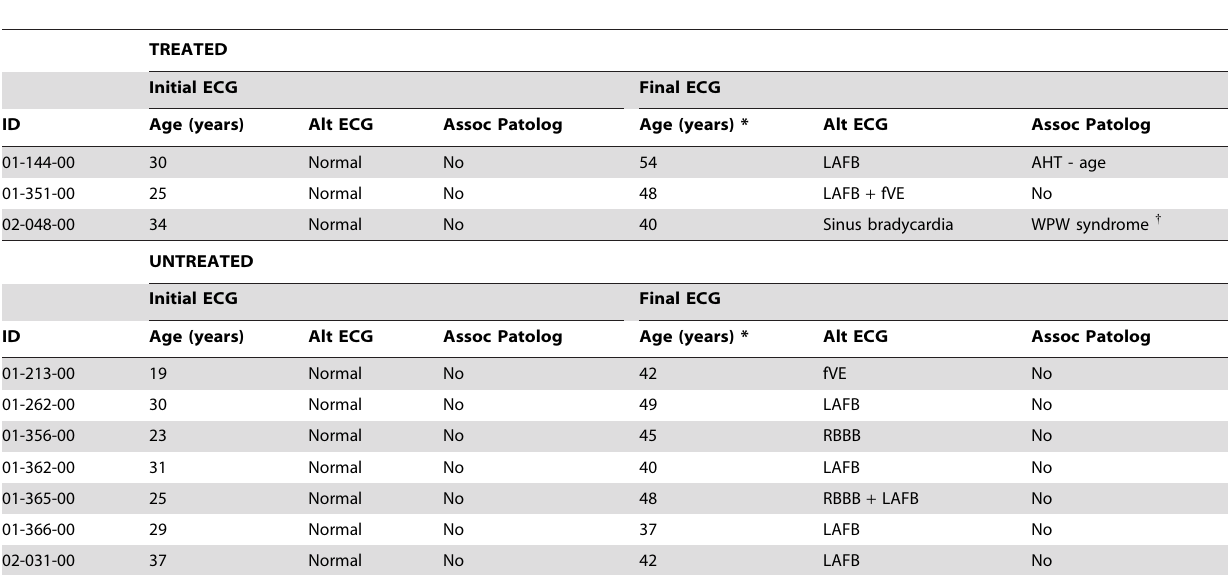
Table 4. Evolution of electrocardiographic alterations compatible with chronic Chagas cardiomyopathy (CCC) that appeared during follow-up in women treated and untreated with trypanocides, Argentina.